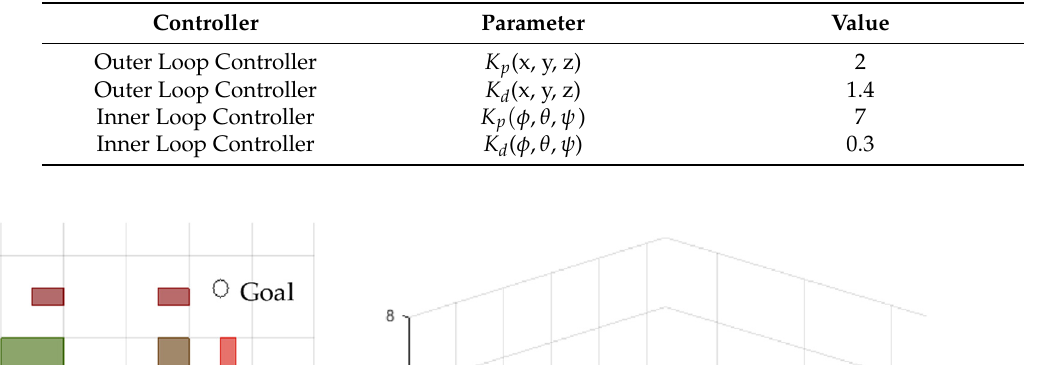
Table 2. Controller gains.